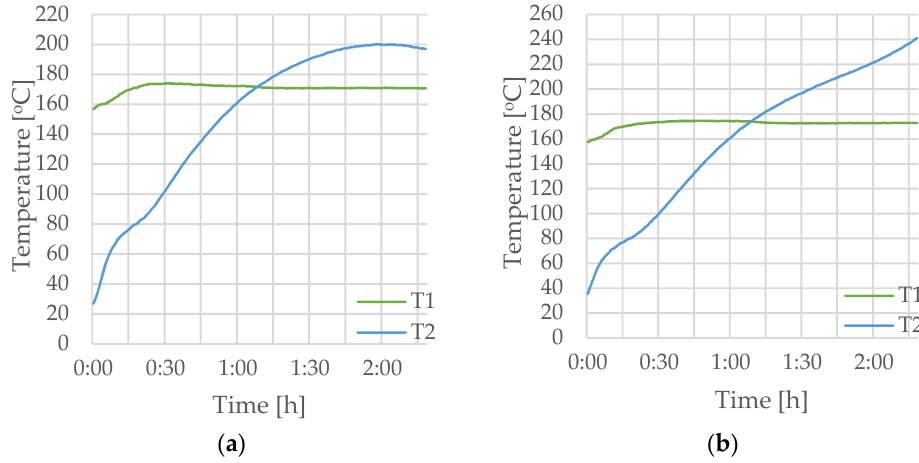
Figure 8. The temperature of sludge pellets in a 50.27 cm 3 basket: ( a ) at a furnace temperature of 170 ◦ C with no evidence of dust ignition, ( b ) at a furnace temperature of 172 ◦ C with a dust